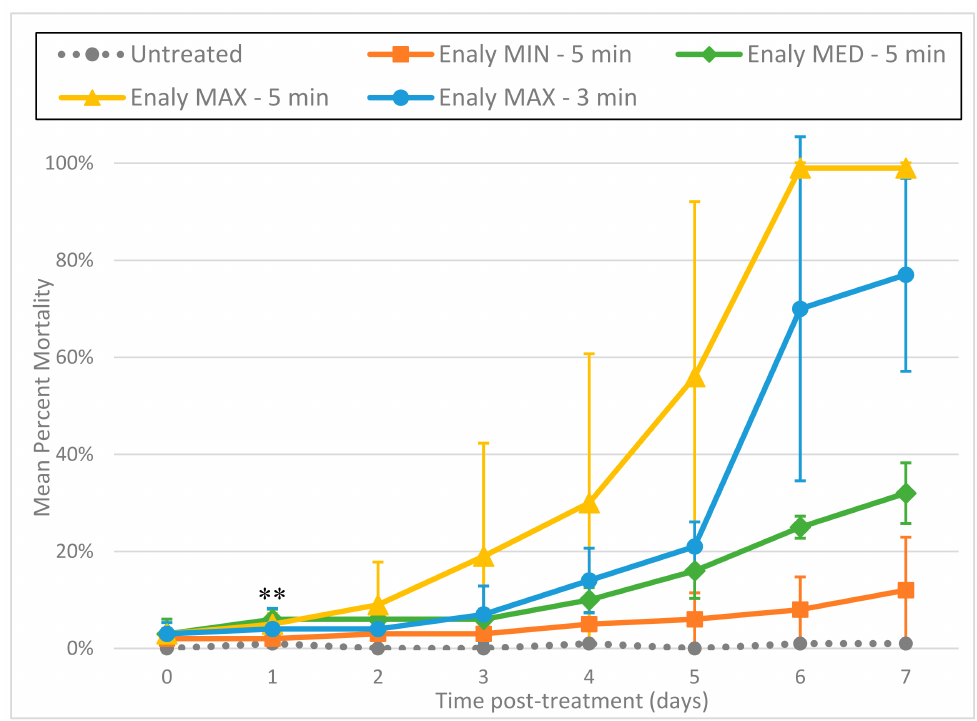
Figure 3. Enaly OZX-300 using direct gas delivery through an air stone at a concentration of ap- proximately 4.5–7.9 mg/L. Comparison of mean percentage mortality rate per day (PI death assay) in response to 3 ozone outputs (minimum, medium, and maximum). All tests were conducted in triplicate. ** All 4 treatments were statistically significant as compared to untreated controls by day 1 ( p ≤